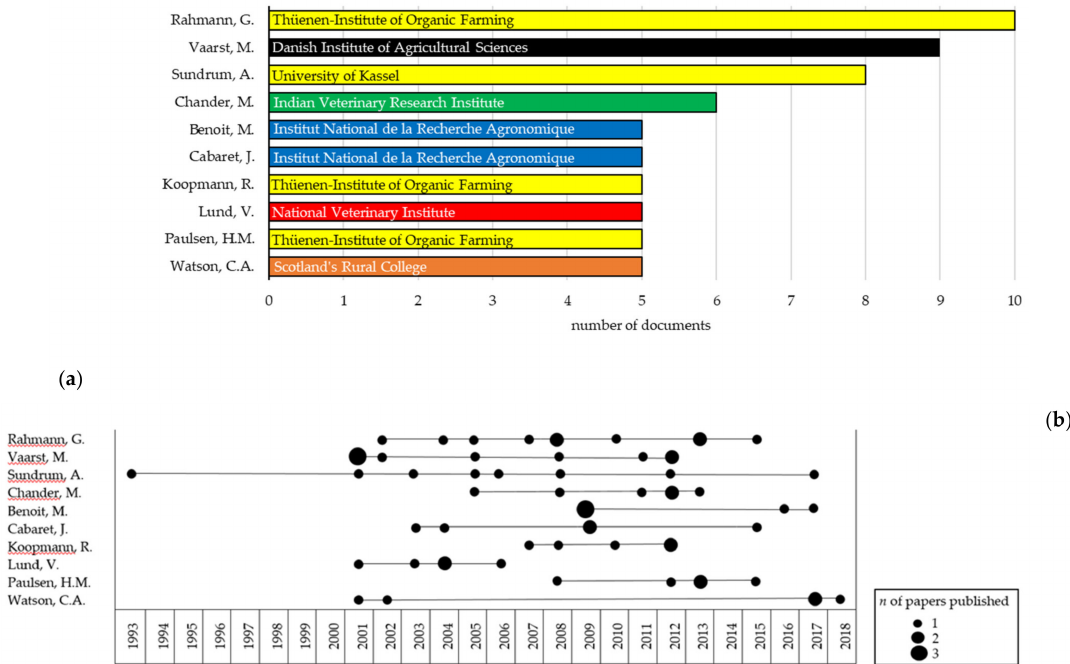
Figure 6. ( a ) Number of documents published by the 10 most productive authors from 1993 to 2018 on organic livestock farming. Current a ffi liation of the authors and country (orange, the United Kingdom; yellow, Germany; red, Norway; blue, France; green, India; and black, Denmark) are provided; ( b ) Papers published by the 10 most productive authors in a timeline scale. Publications were retrieved from Web of Science Core Collection using the following keyword combinations: Organic + Livestock + Farming and Organic + Husbandry +